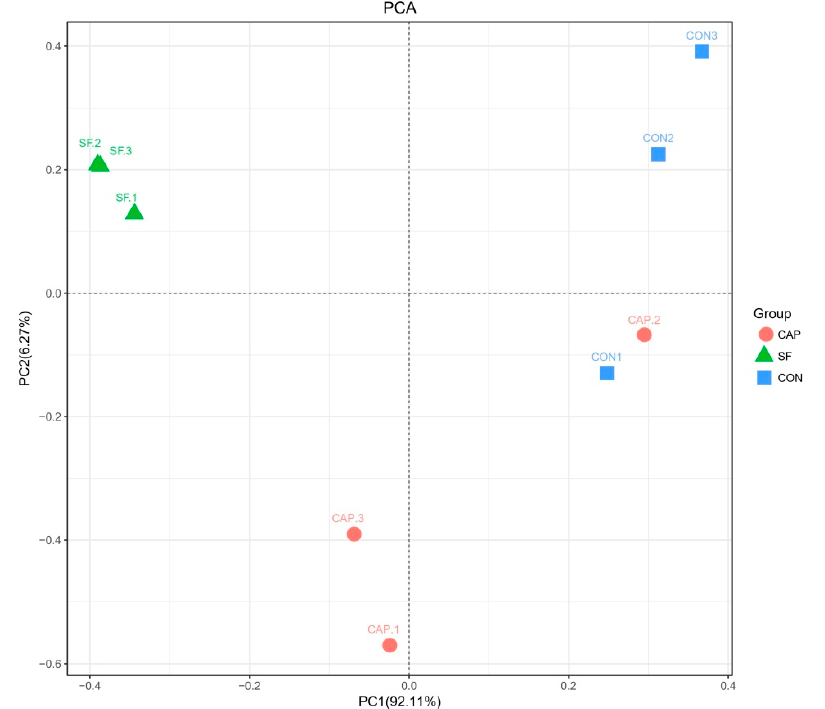
Figure 1. Principal component analysis of the bacterial community in wet brewers grains ensiled with sodium formate and calcium propionate after 20 days (CON, control group; SF, sodium formate; CAP, calcium propionate; 1, 2, 3, three replicates for each treatment).